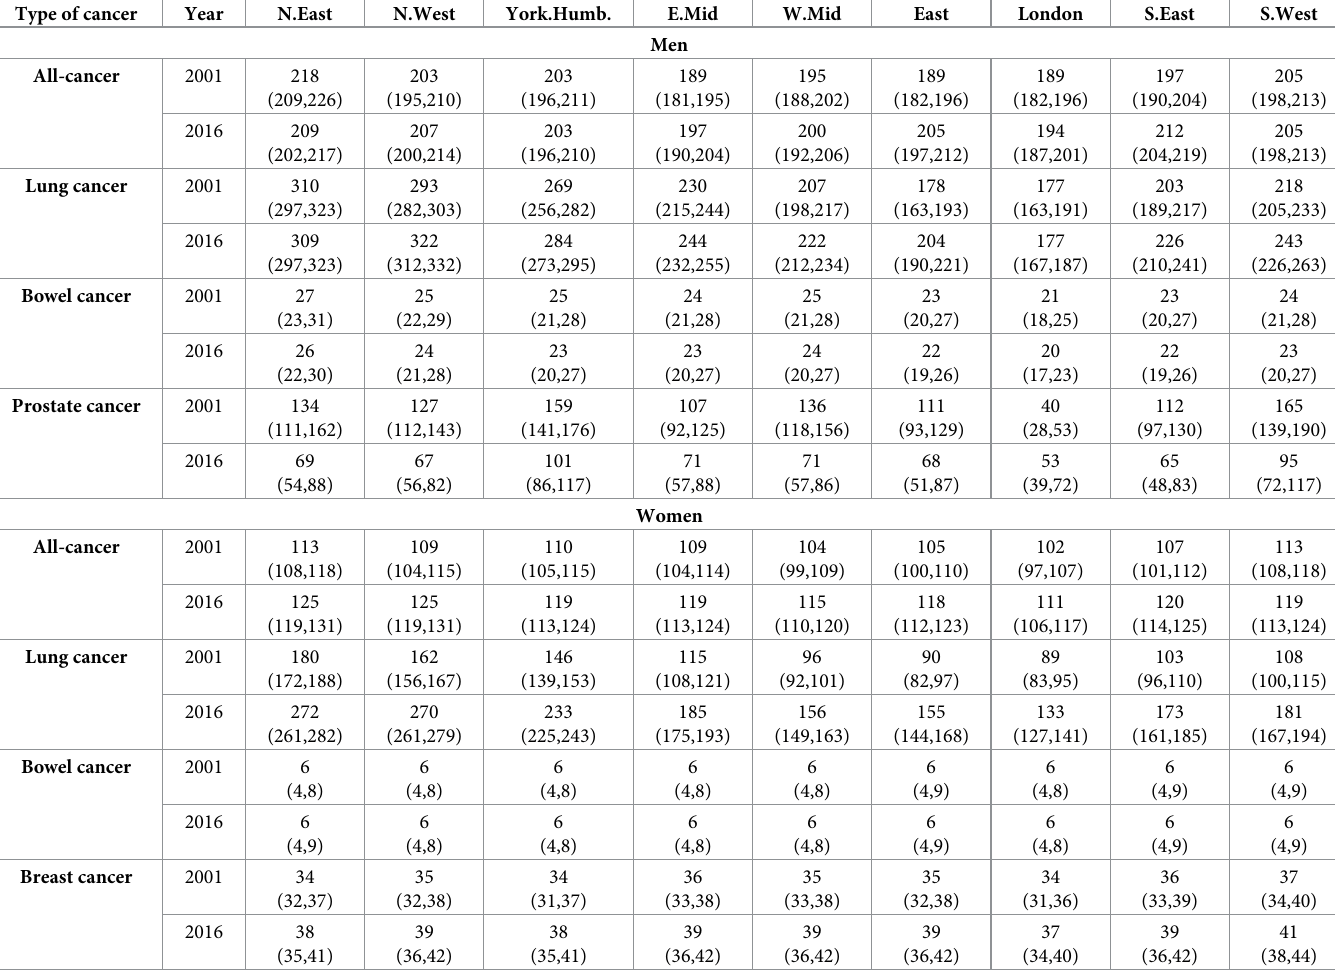
Table 5. Absolute deprivation differences (AD t , r ), per 100,000 people, in age-standardised fitted incidence rates in 2001 and 2016 for all regions in England and both genders; 95% credible intervals in brackets. Type of cancer